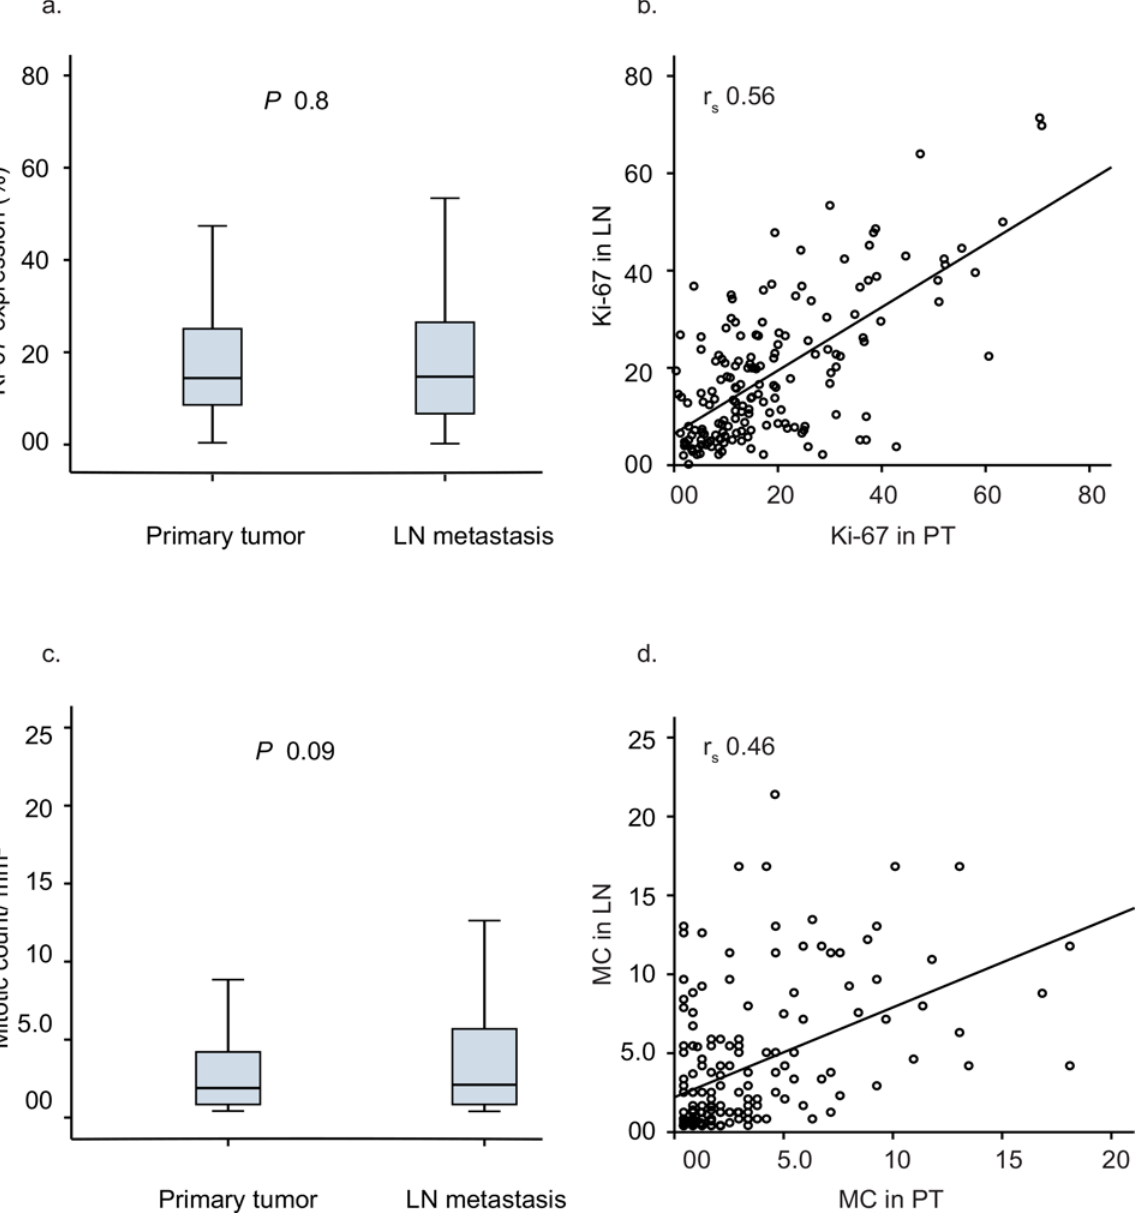
Fig 1. Proliferation markers in primary tumors and lymph node metastases. Box plots (a. and c.) Horizontal lines inside the boxes represent the median values; box limits indicate the 25 th and 75 th percentiles. Scatter plot (b. and d.) for % Ki-67 and MC in PT and LN